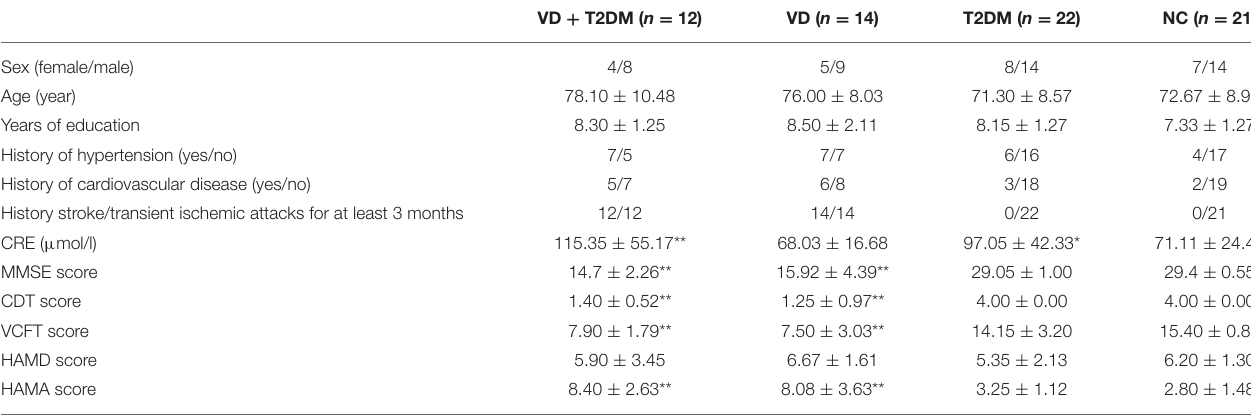
TABLE 1 | Demographic and clinical characteristics of subjects and the numbers of samples for the NC, VD, T2DM, VD + T2DM groups.